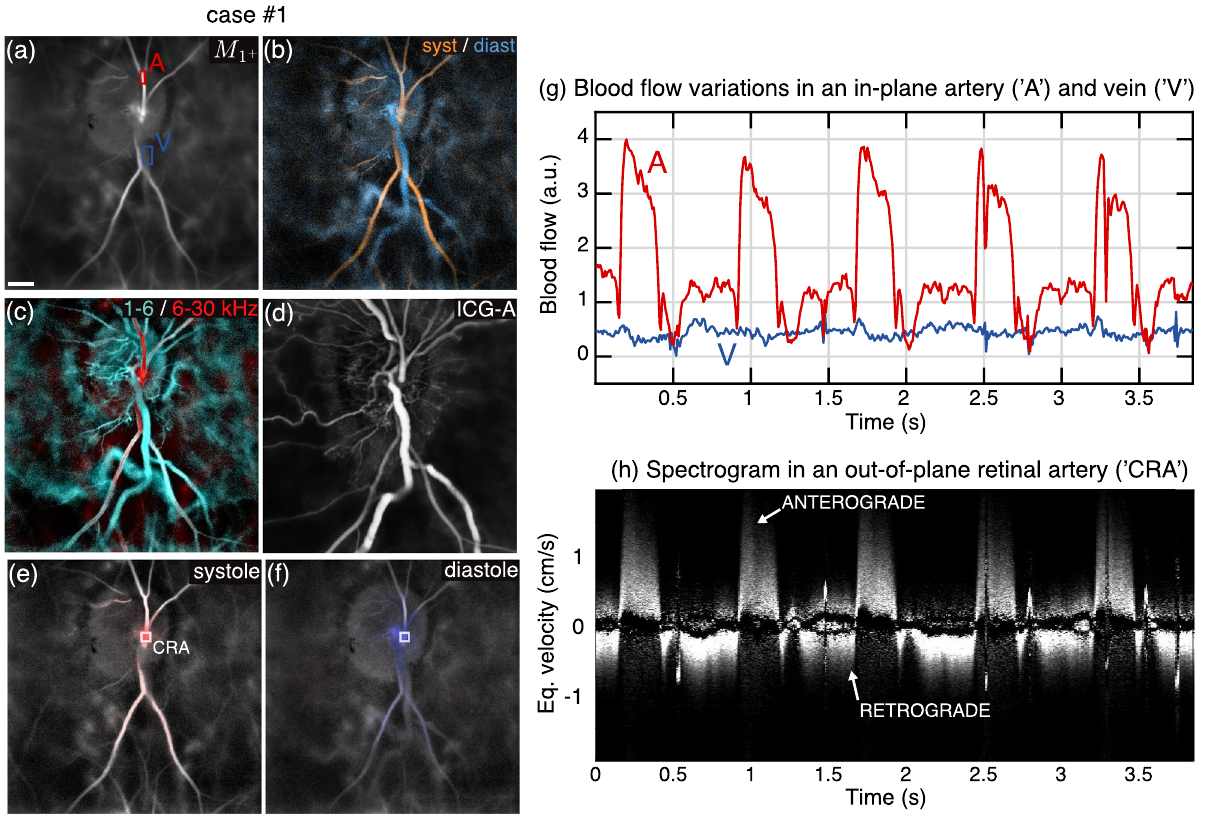
Figure 6. Blood flow reversal in the central retinal artery in a case of high tension glaucoma/CRVO. ( a ) Averaged blood flow image. ( b ) Systolodiastolic image. ( c ) Color composite Doppler image of low/high flow in red/cyan. ( d ) ICG-Angiogram. ( e , f ) Directional blood flow during systole and diastole. ( g ) Blood flow measured in an in-plane artery ‘A’ and vein ‘V’. ( h ) Spectrogram measured in ‘CRA’. Visualization 3 shows the directional blood flow movie juxtaposed to the arterial spectrogram. Visualization 4 shows the dynamic ICG-angiography. The estimated size of the scale bar is 500 µ